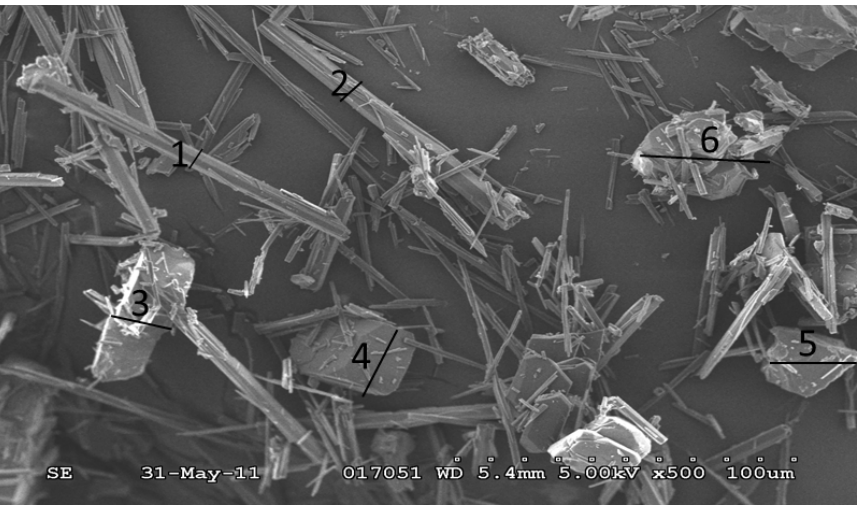
Figure 9. SEM picture of the sample taken at 20 min in Run 2. Crystals 1 and 2 are considered to be Form II and 3-6 as Form III.